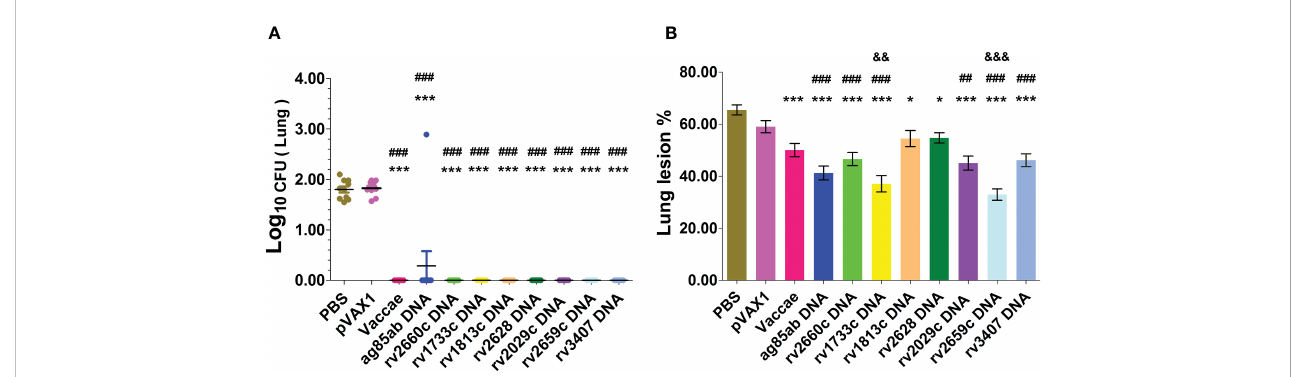
FIGURE 3 The bacterial lords and histopathological changes in the lung tissues were obtained from mice at 3 w after stopping hydroprednisone injection. (A) CFUs of live MTB in mouse lungs; (B) Lung lesion area%. Comparison with PBS group: * P < 0.05, *** P < 0.0001; Comparison with pVAX1 vector group: ## P < 0.01, ### P < 0.0001. Comparison with Vaccae vaccine group: && P < 0.01, &&& P <